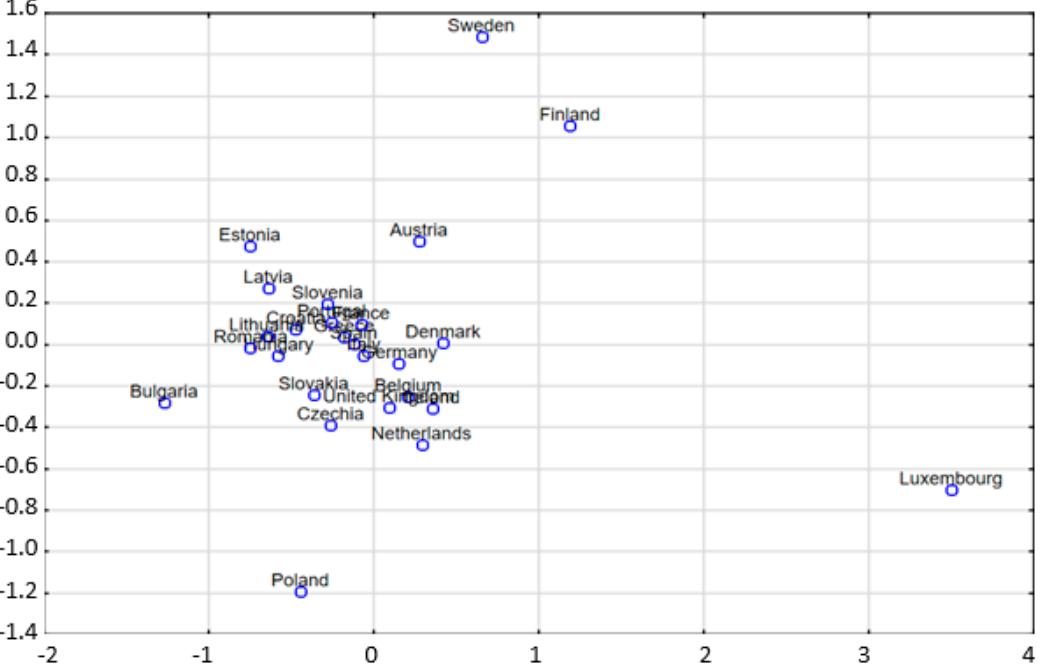
Table 5. The set of variables standardized for a 2018 year (own study).